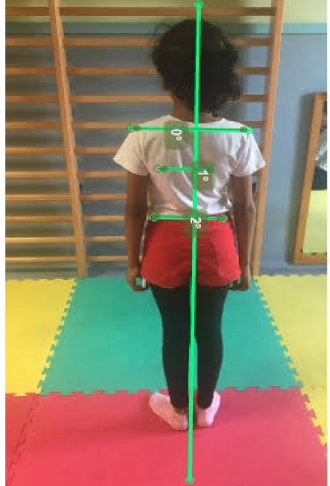
Figure 6. Back capture and representation of the horizontal tracings between the bone structures and the vertical line for the calculation of the degrees in the measurements through the Kinovea